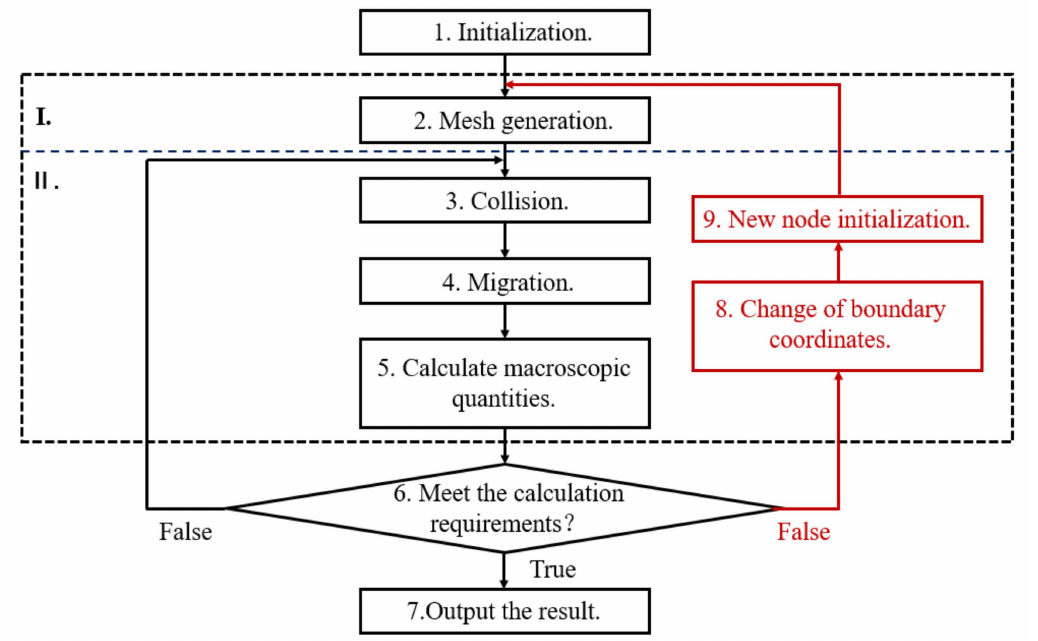
Figure 3. Flow chart of LBM stationary boundary and moving